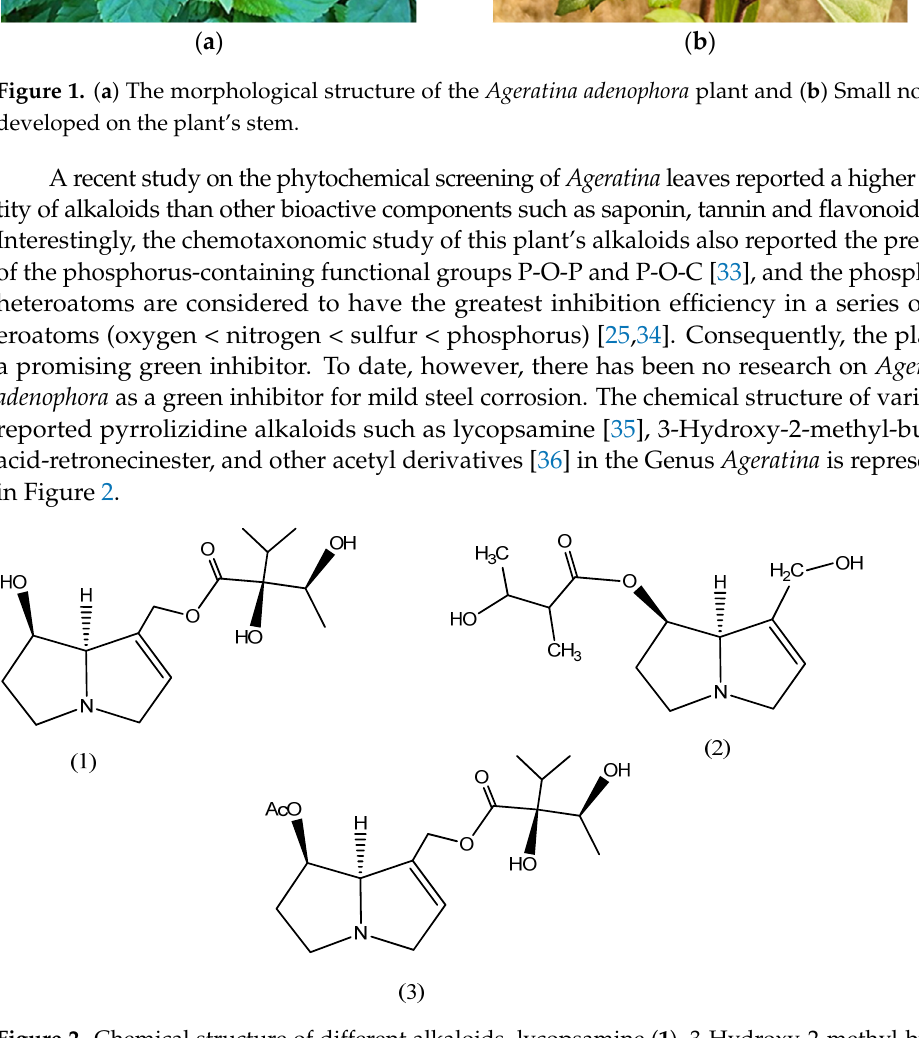
Figure 2. Chemical structure of different alkaloids, lycopsamine ( 1 ), 3-Hydroxy-2-methyl-butyric acid-retronecinester ( 2 ), and Acetyl-lycopsamine ( 3 ), in the Ageratina adenophora plant.